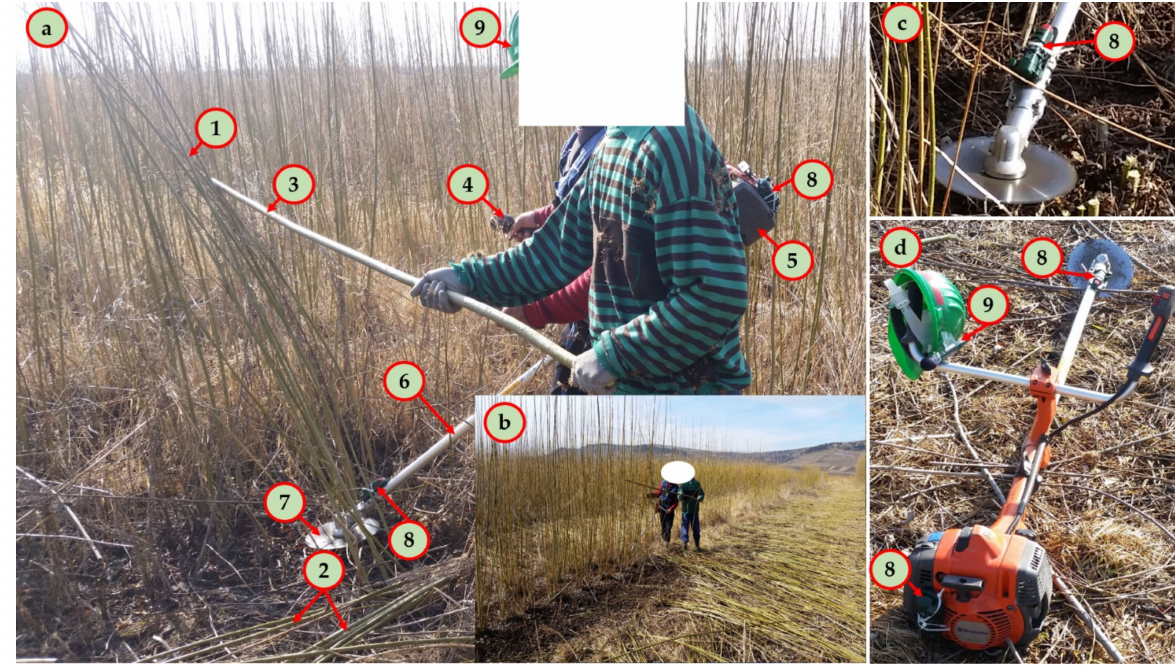
Figure 1. Work organization, tool description and instrumentation of data collection. Legend: ( a )—the typical work organization (1—bunch of stems to be felled, 2—bunches of felled stems, 3—wooden stick used to direct the felling, 4—throttling control, 5—engine, 6—transmission shaft, 7—steel blade, 8—triaxial accelerometer, 9—helmet equipped with a sound pressure level datalogger), ( b )—the general layout of the felling operations (example from Poian 1 location, close to finishing the felling work in a plot), ( c )—detail of the acceleration datalogger (8) placed on the shaft, ( d )—details on the instrumentation used to collect the data (8—triaxial accelerometers, 9—sound pressure level